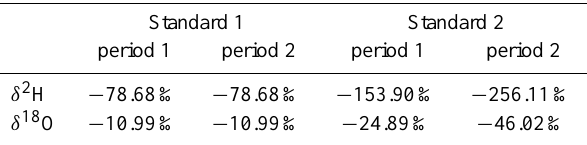
Table 3. Isotopic composition of the standards used for calibration of the laser water vapour isotope measurements for 1 August 2011 to 18 November 2011 (period 1) and 18 November 2011 to 31 De- cember 2011 (period